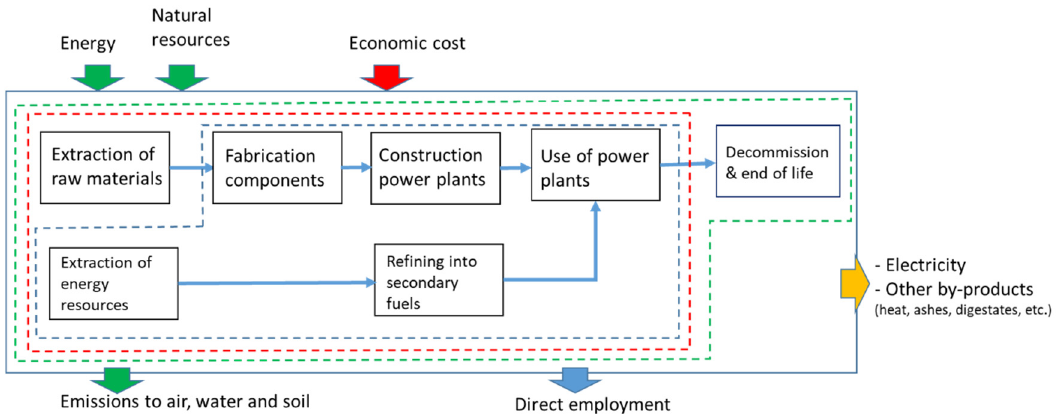
Figure 1. Life cycle diagram, system boundaries and input/output consideration employed to evaluate the environmental (green), economic (red) and socio-economic (blue) sustainability of Spain’s electricity system.